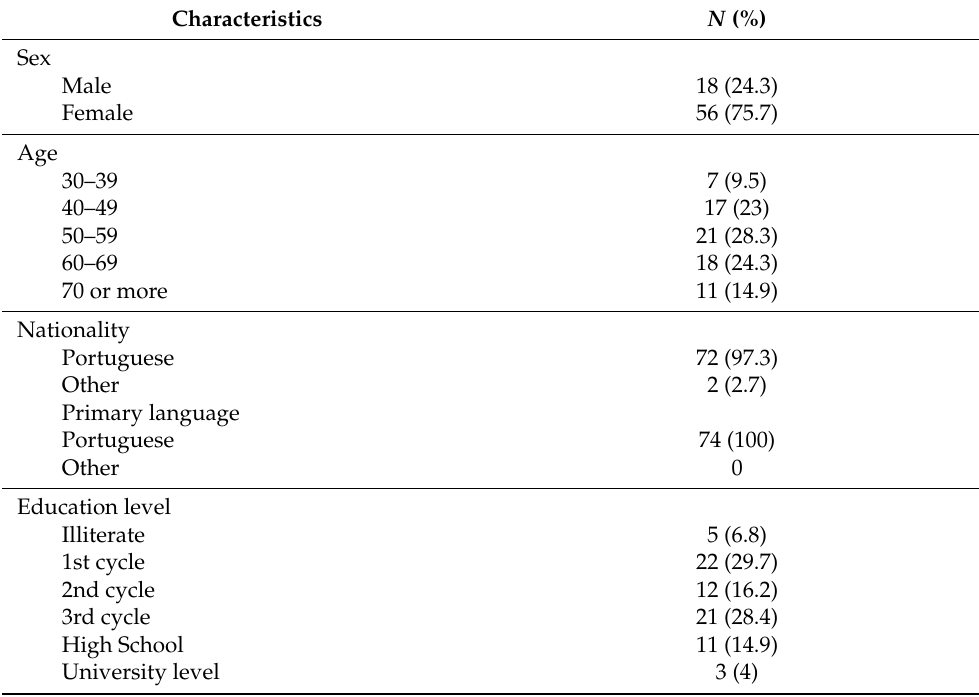
Table 2. Fresh fishery product retailers managers’ socio-demographic data obtained from